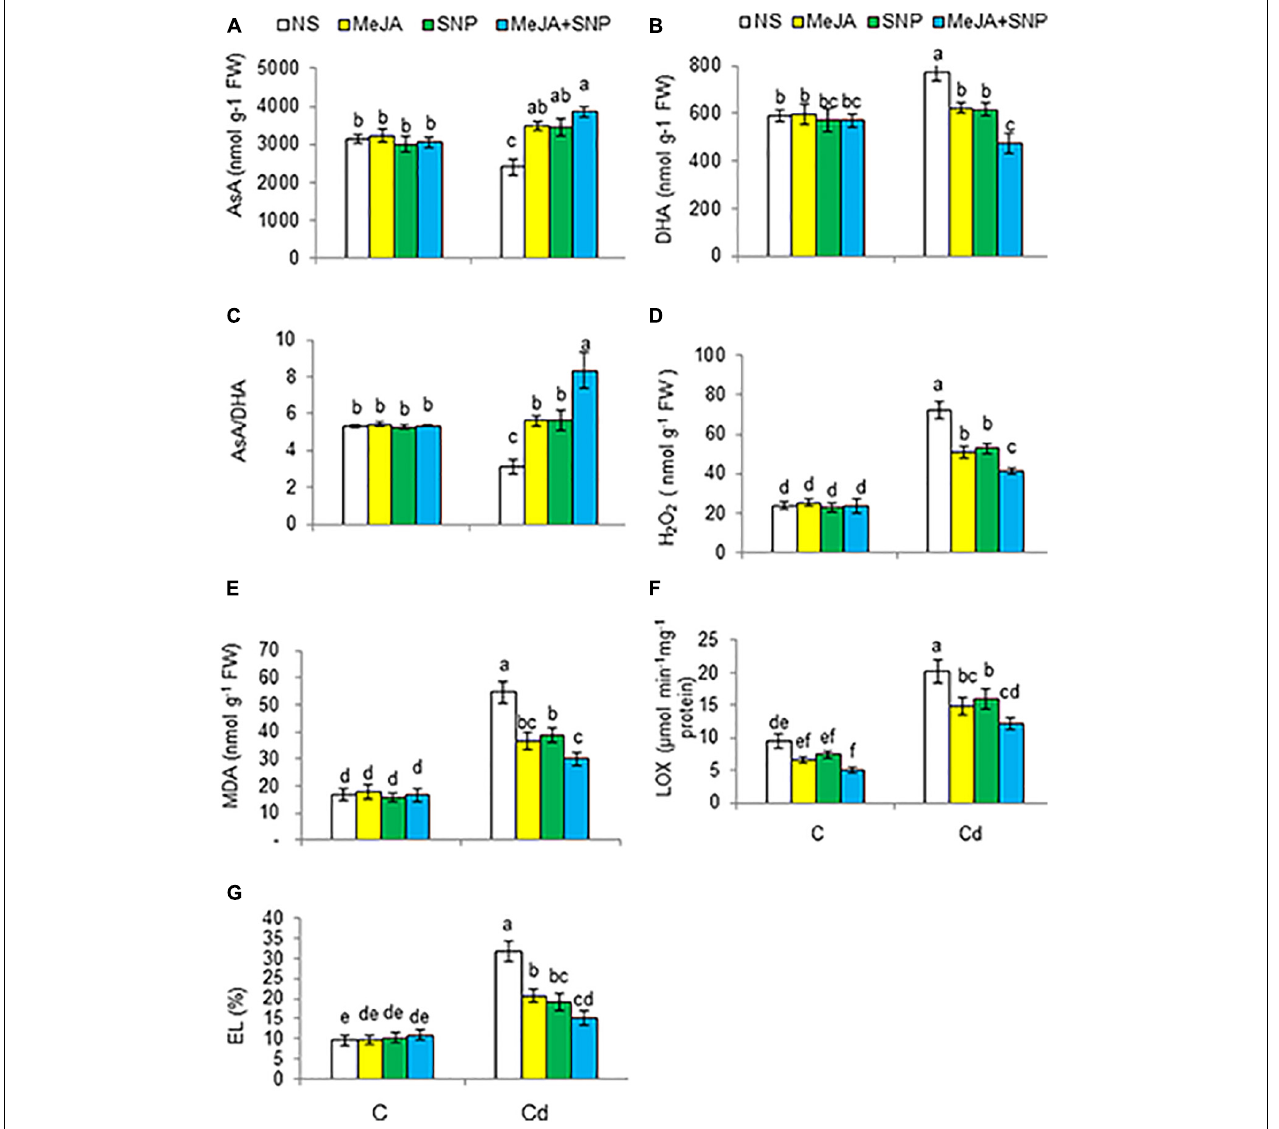
FIGURE 6 | Ascorbate [AsA (A) ], and dehydroascorbate [DHA (B) ] on fresh weight (FW) basis, and AsA/DHA ratio (C) , hydrogen peroxide [H 2 O 2 (D) ], malondialdehyde [MDA (E) ] on FW basis, lipoxygenase [LOX (F) ], and electrolyte leakage [EL (G) ] in wheat plants grown under control (C) and cadmium (100 µ M Cd) and sprayed with 10 µ M methyl jasmonate (MeJA) or 100 µ M sodium nitroprusside (SNP) alone or together (mean ± SE). Mean values carrying different letters within each attribute differ significantly ( P ≤ 0.05) based on Duncan multiple-range